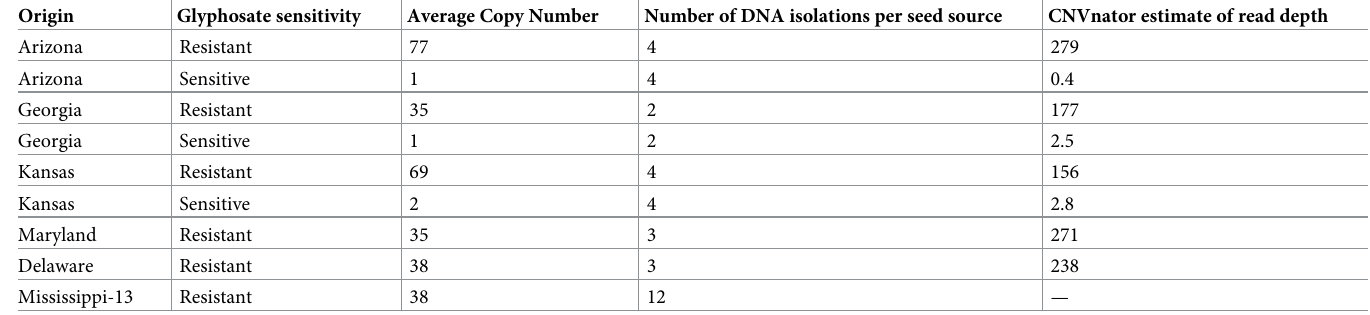
Table 1. EPSPS copy numbers for the eight biotypes, five GR and 3 GS, used herein by qPCR compared to the copy number variation (CNV) determined by the CNVnator program. Origin Glyphosate